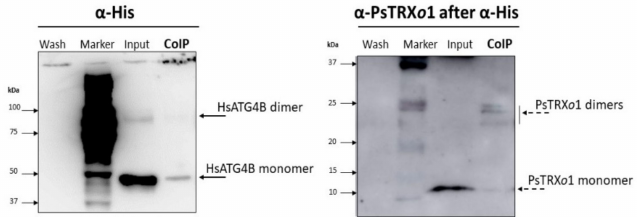
Figure 11. Western blot of the resulting Co-IP between His-HsATG4B and PsTRX o 1 recombinant proteins revealed with anti-Histidine and anti-PsTRX o 1 after mild stripping. The first lane contained the last wash before elution of the coimmunoprecipitated (CoIP) complexes from the microparticles to check the absence of any of the proteins. The second lane contained the Marker of molecular weights with the corresponding numbers in kDa. The input lane corresponds to a fraction of both proteins incubated before passing through the column and the last lane contained the CoIP proteins revealing the interaction between HsATG4B and PsTRX o 1 in their monomeric and dimeric forms.